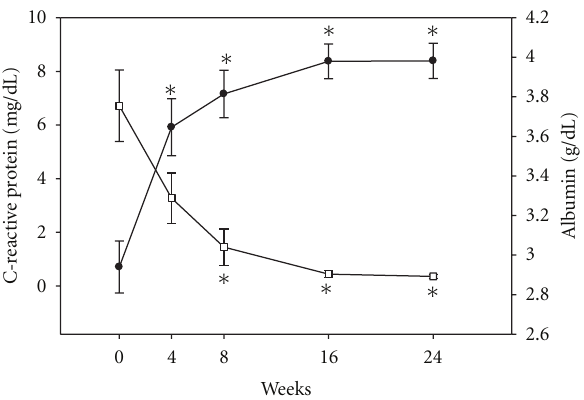
Figure 3: Phase angle during treatment. Average phase angle (shown on Y axis) by bioelectrical impedance analysis at each study week. ∗ P = 0.005 compared to week 4. Whiskers represent standard errors. † P = 0.01 compared to week